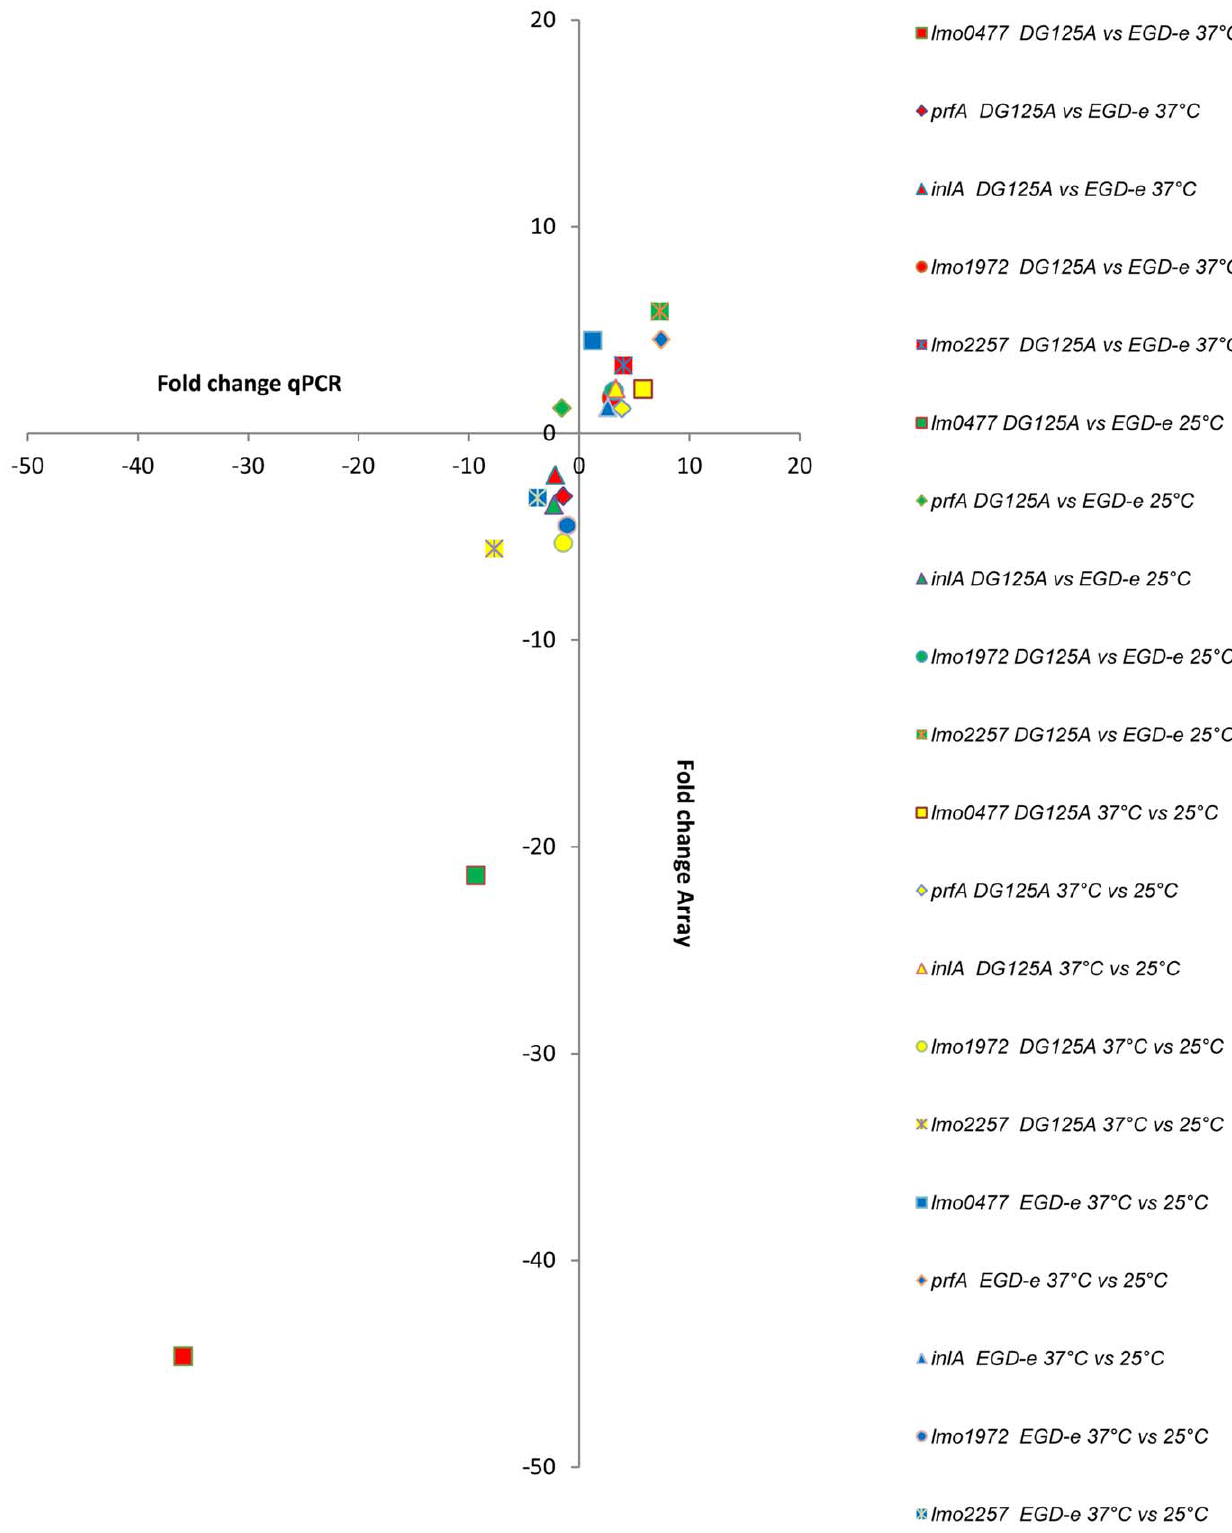
Figure 6. Comparison of fold-changes determined from microarray and reverse transcriptase real time PCR data. ( % ) lmo0477 , ( e ) prfA , ( D ) inlA , ( O ) lmo1972 , ( ) lmo2257 ; red : DG125A versus EGD-e 37 u C, green : DG125A versus EGD-e 25 u C, blue : EGD-e 37 u C versus 25 u C, yellow : DG125A 37 u C versus 25 u C.